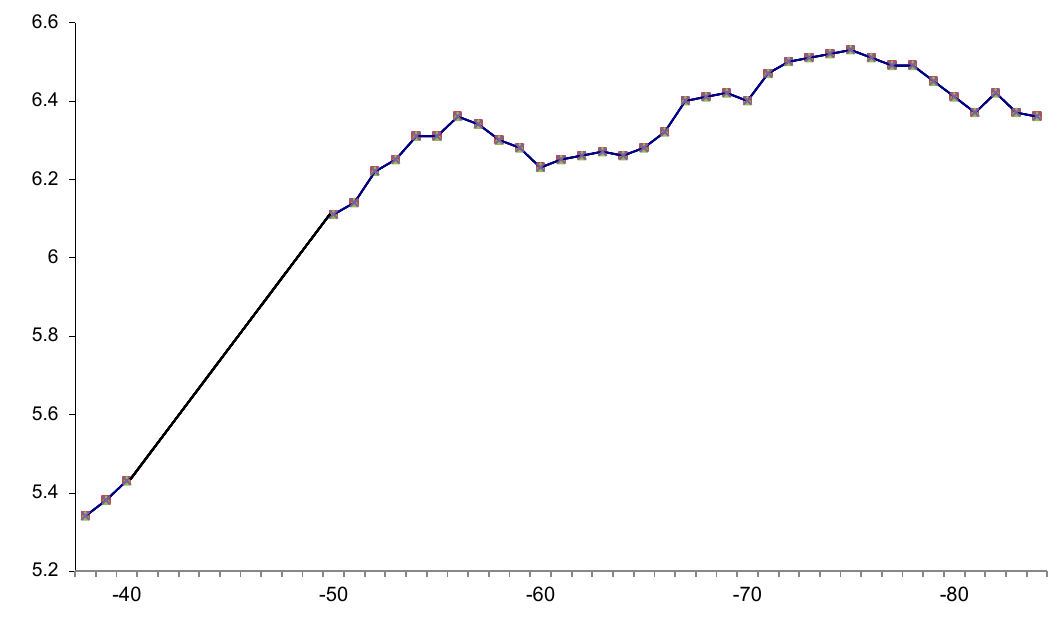
Figure 1. Intelligence test scores (IQ units) of military conscripts in the birth years 1938 to